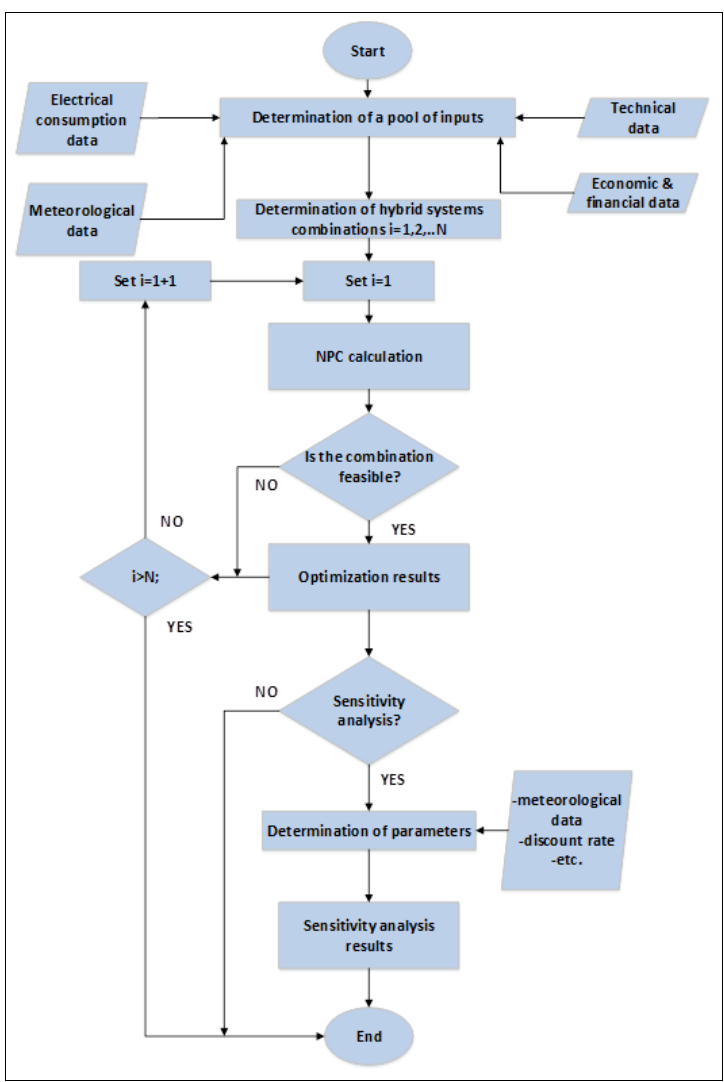
Figure 1. Flow-chart of the